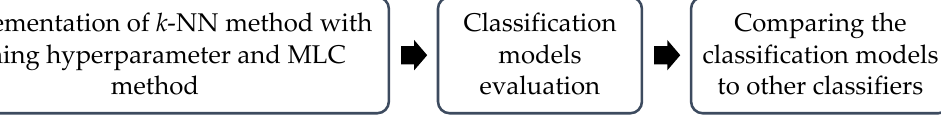
Figure 3. Steps in garlic field classification.